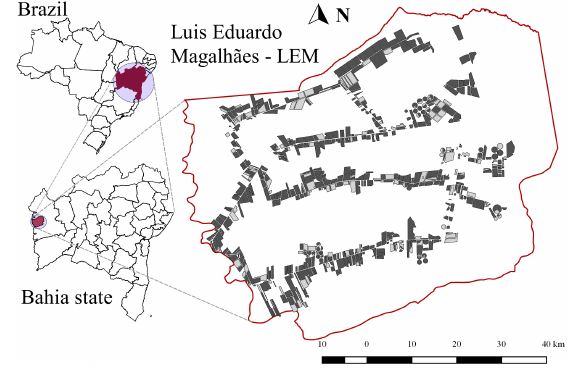
Figure 4. Luis Eduardo Magalh˜aes (LEM) municipality. Polygons correspond to the ground truth parcels in LEM 17/18